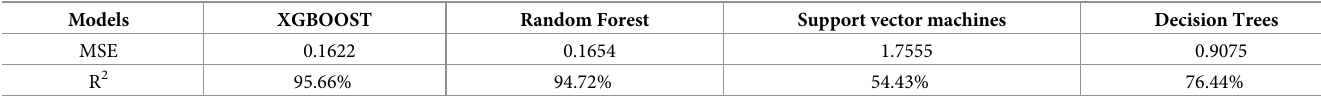
Table 3. Parameter comparison of the maximum prediction.